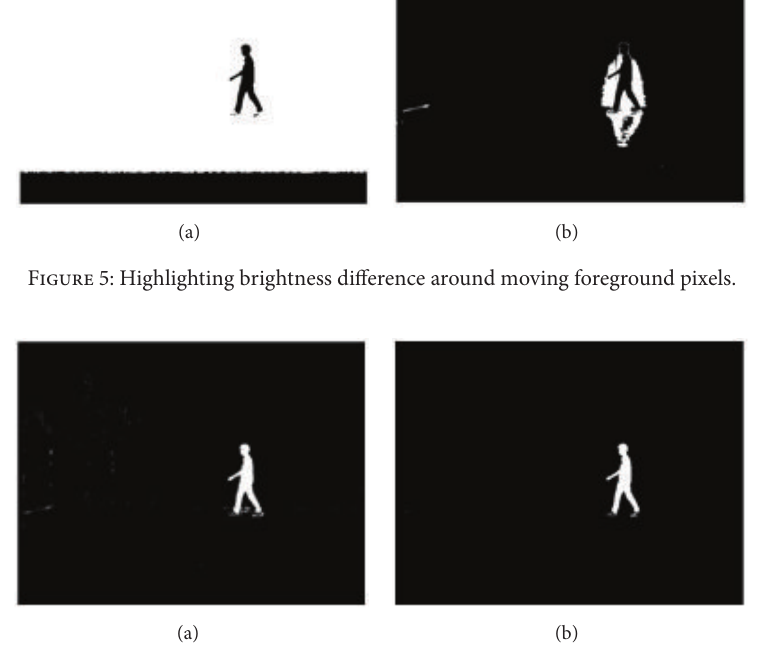
Figure 6: Resultant foreground image. (a) Foreground with random noise (b) Postprocessed foreground